Question: Identify the chart type used in this figure.
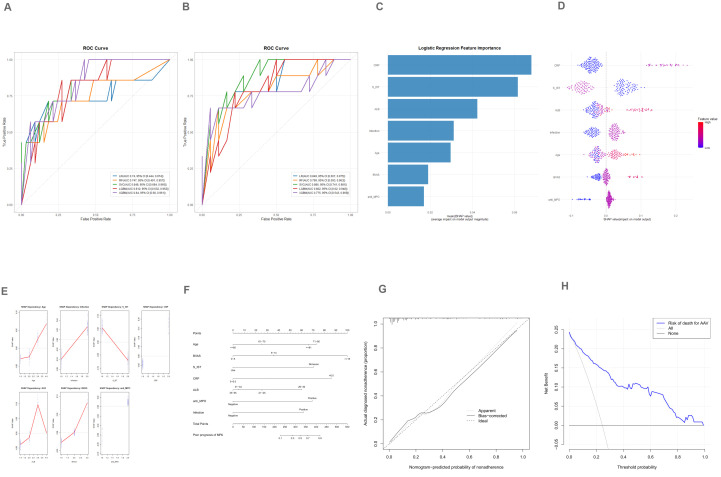
Answer: line